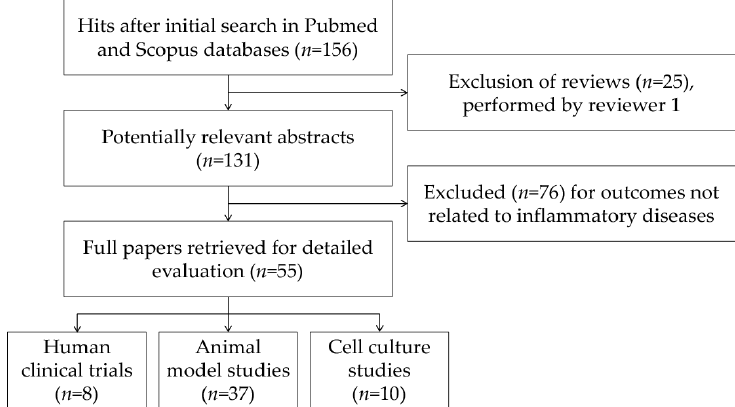
Figure 3. Flow chart of papers included in the review.